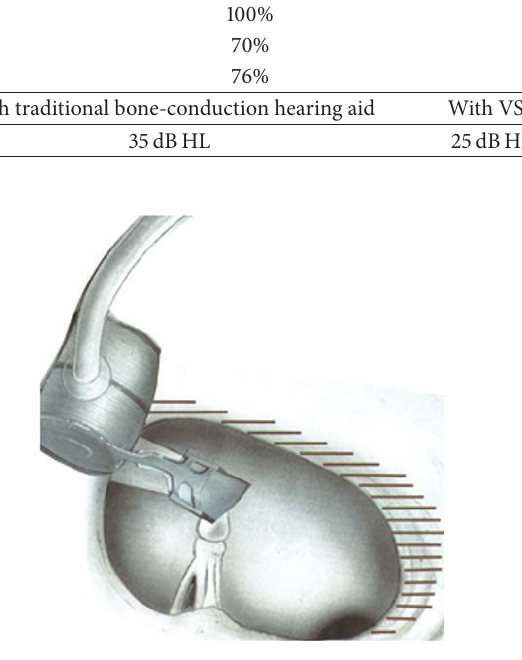
Figure 3: Middle ear implant application. The FMT was placed to the long apophysis of the incus with superior